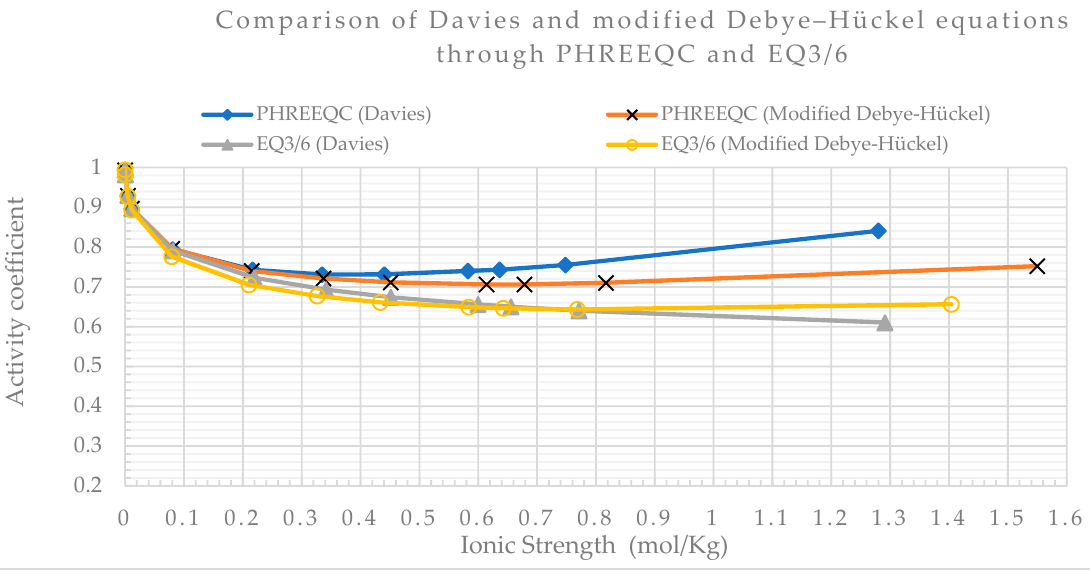
Figure 13. Dependence of the activity coefficient of Na + on the ionic strength in a range up to 0.5 mol/kg through EQ3/6.